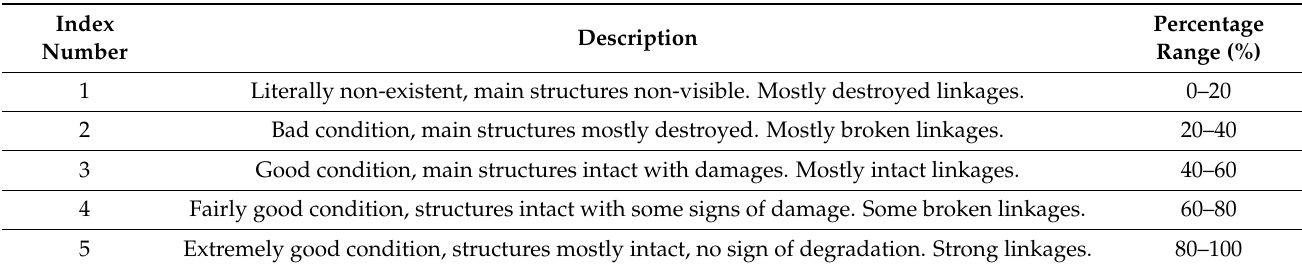
Table 1. The AR physical condition evaluation based on the index table adopted from Sheng [53]. Description